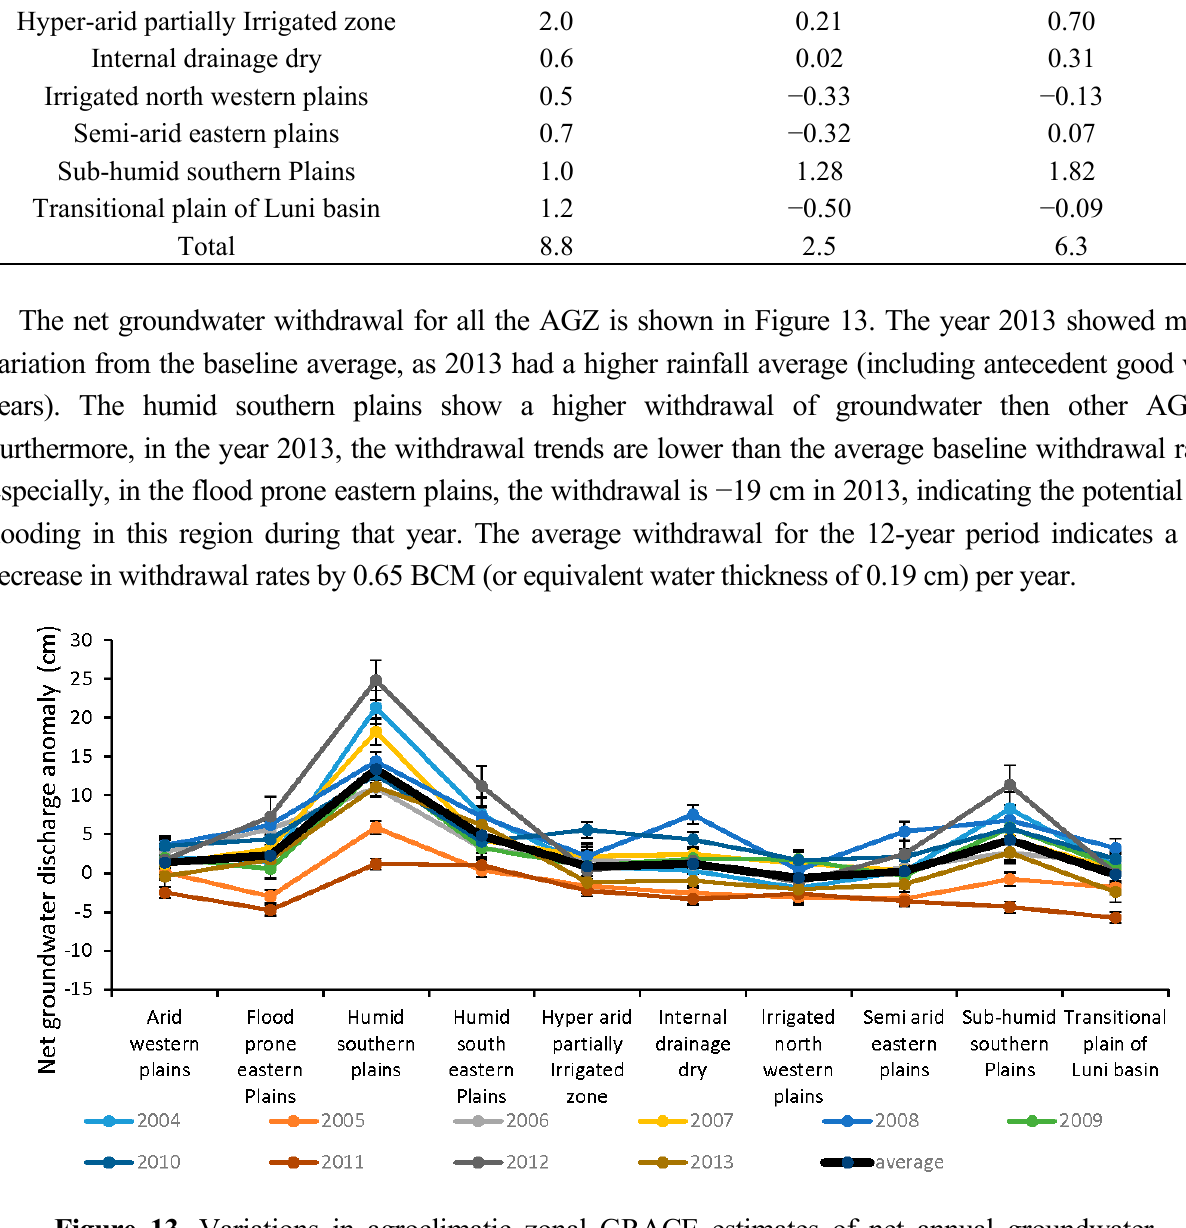
Figure 13. Variations in agroclimatic zonal GRACE estimates of net annual groundwater storage discharge (June–October) in the Indian state of Rajasthan. Bars indicate standard